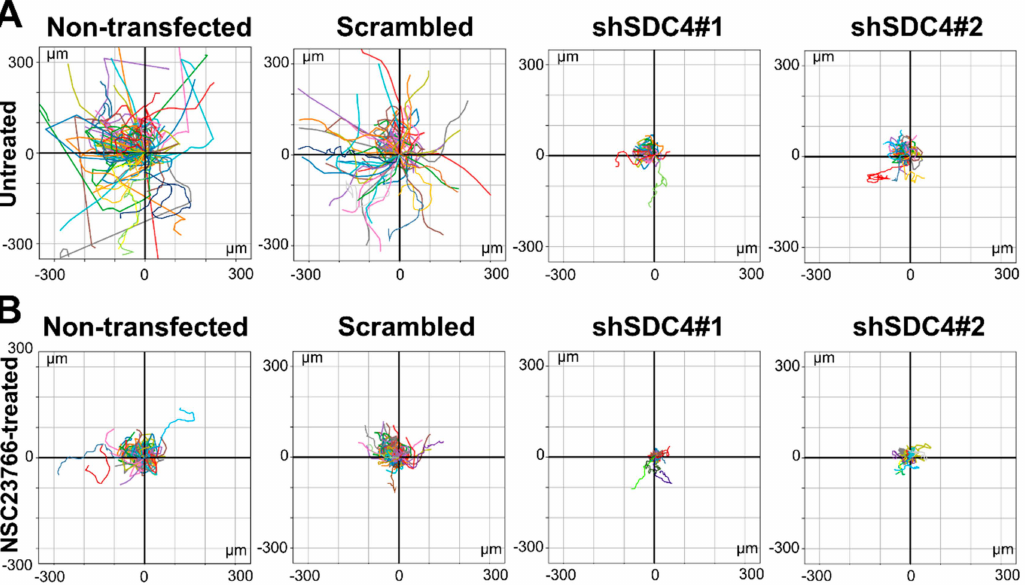
Figure 2. Representative wind-rose plots depict the total path of the cells. The trajectories were shifted to a common origin. Each colored line represents the total path of a single untreated myoblast either without ( A ) or with NSC23766 treatment ( B ) in the di ff erent cell lines. Total duration of live cell microscopy: 18